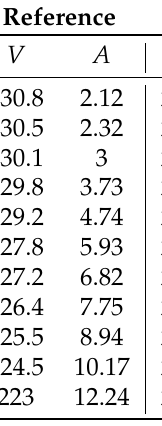
Figure 5. Resistive voltage divider test. Error 2.28%.